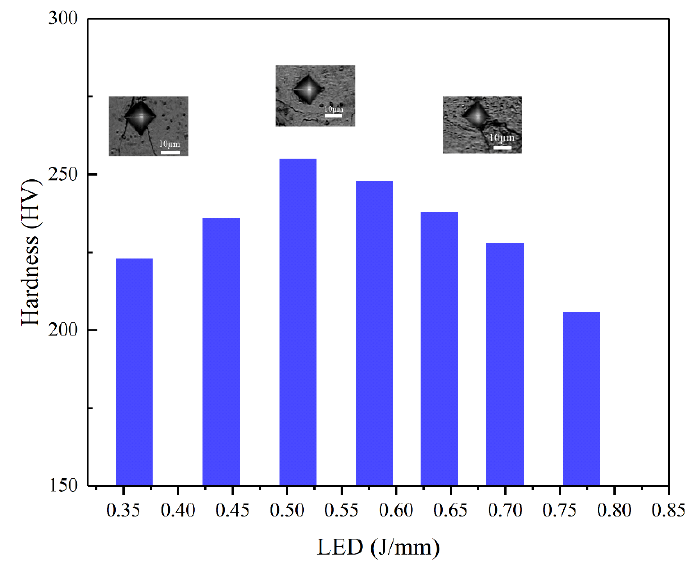
Figure 9. The effect of laser energy density on microhardness of SLM fabricated molybdenum. The bending strength of SLM-ed Mo reached 280 ± 52 Mpa. The fracture surface of molybdenum in different magnifications are given in Figure 10. The white arrow is the building direction of the sample. The fracture mode is almost exclusively intergranular.